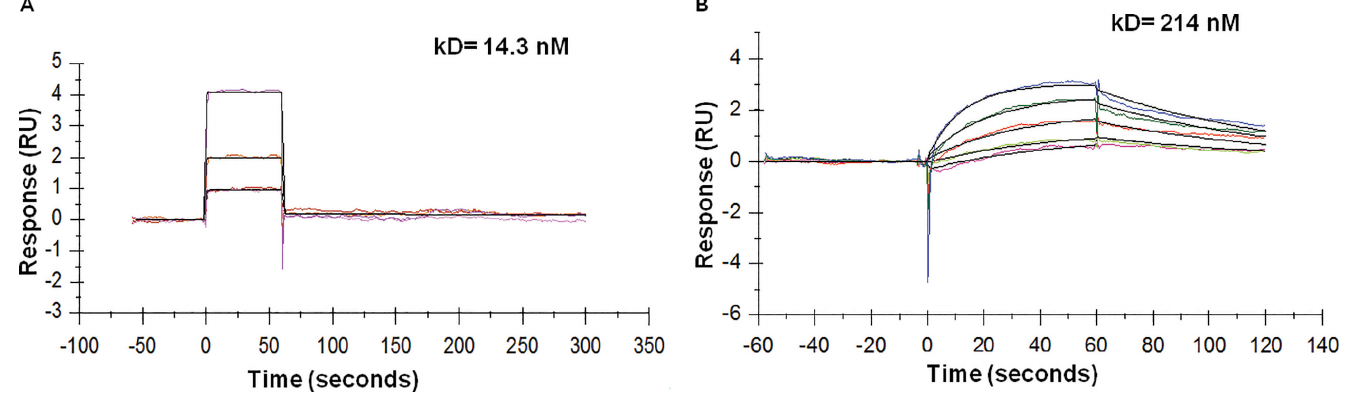
Figure 3. Emetine binds to ATGL with high affinity. Surface plasmon resonance analysis was conducted by immobilizing ATGL on a CM5 dextran biosensor chip surface (see Materials and Methods). (A) ATGL ligand of ~300 RU and emetine analyte (0-500 μ mol/L). (B) ATGL ligand at ~ 100 RU, then PEDF (0-1,000 nmol/L) added as an